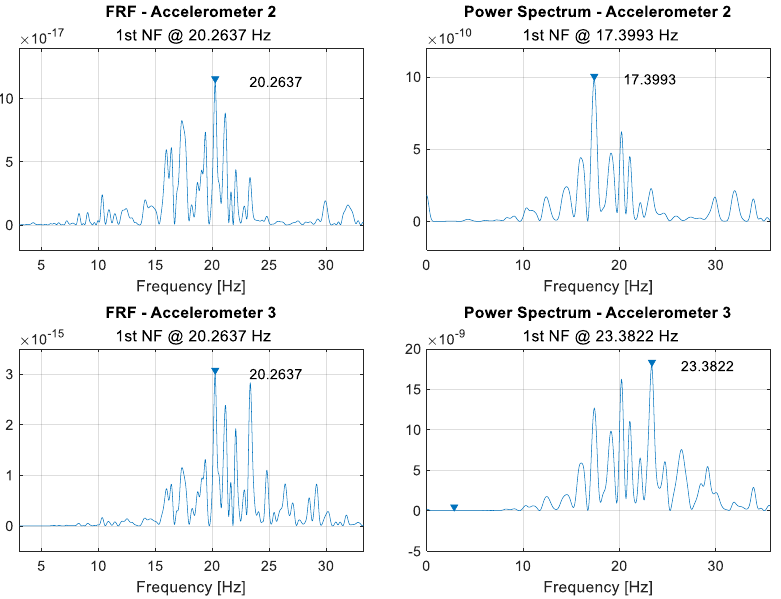
Figure A2. Close-up around first natural frequency, Arduino measurement white noise input, FRF and power spectrum plots, accelerometers 2 and 3 .